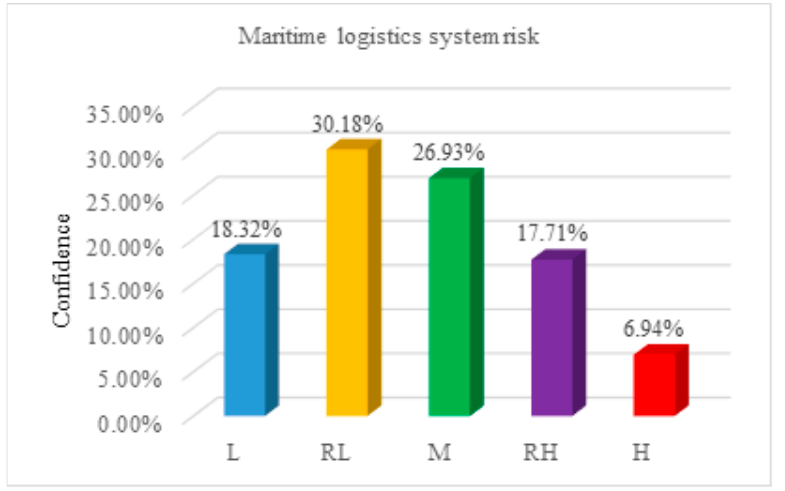
Figure 7. Maritime logistics system risk assessment.